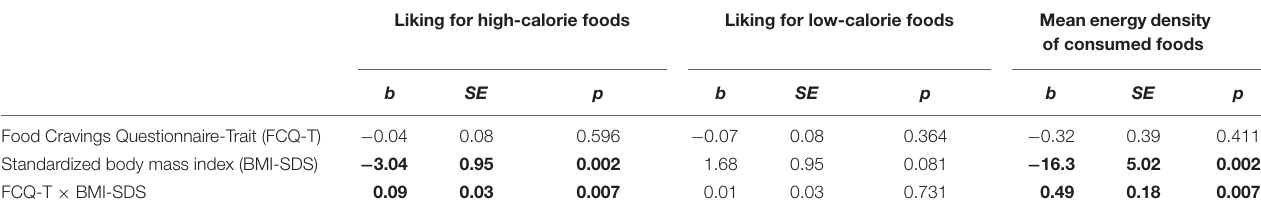
TABLE 2 | Results from linear regression analyses with trait food craving scores and body mass predicting liking for high- and low-calorie foods and mean energy density of consumed foods. Liking for high-calorie foods Liking for low-calorie foods Meanenergydensity